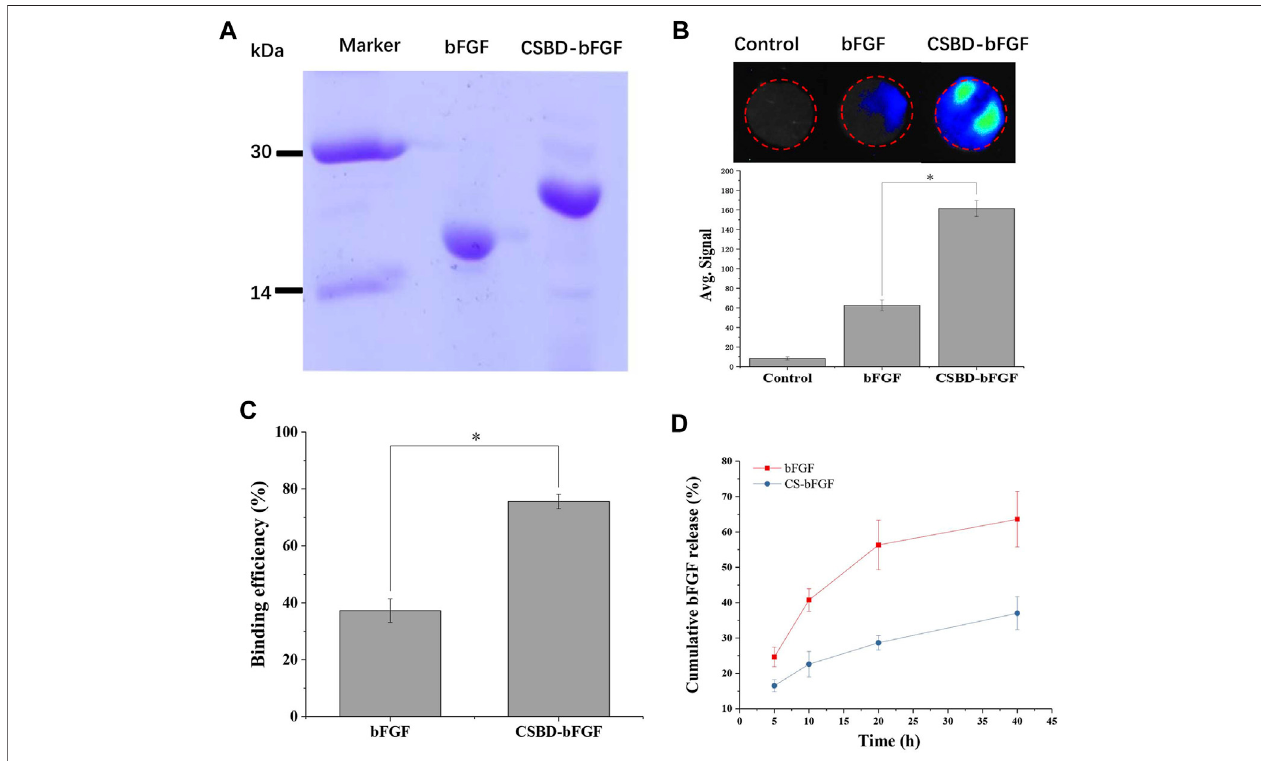
FIGURE 2 | (A) SDS – PAGE of the bFGF and CSBD-bFGF fusion proteins, (B) immuno fl uorescence intensity represented the amount of bFGF and CSBD-bFGF, (C) binding ef fi ciency and (D) cumulative release of bFGF and CSBD-bFGF, p < 0.05, n = 3.